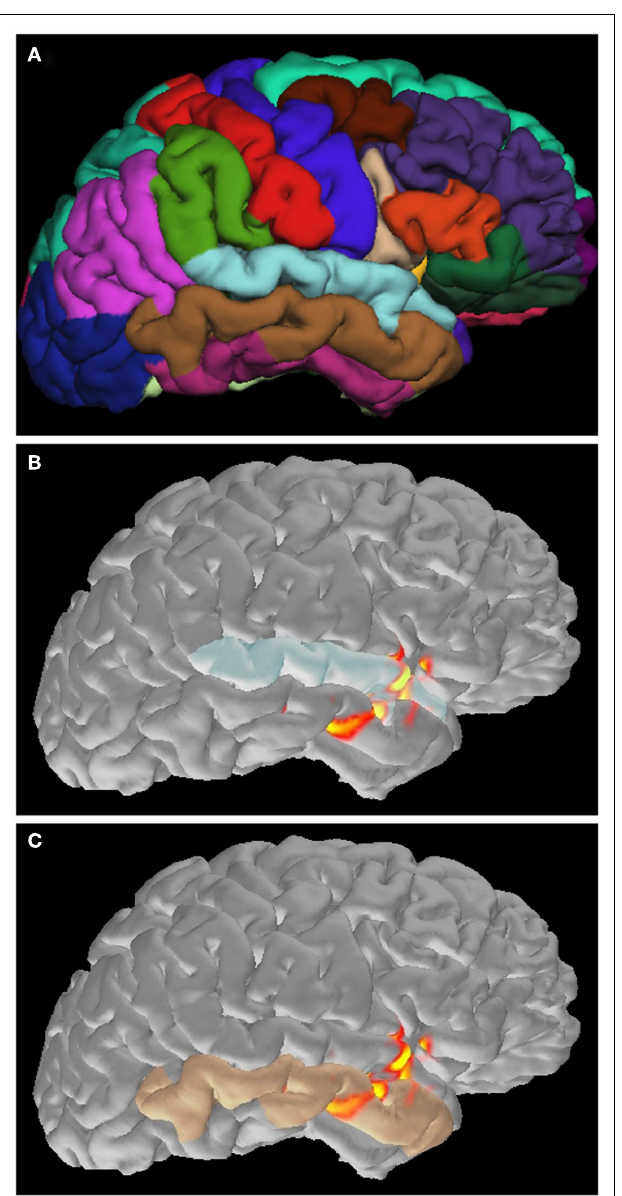
FIGURE 5 |Application of cortical parcellation . Cortical parcellation is obtained by Freesurfer (A) .The parcellation is useful to understand that the spike activation is mainly located in the superior (B) and inferior (C) temporal gyrus.